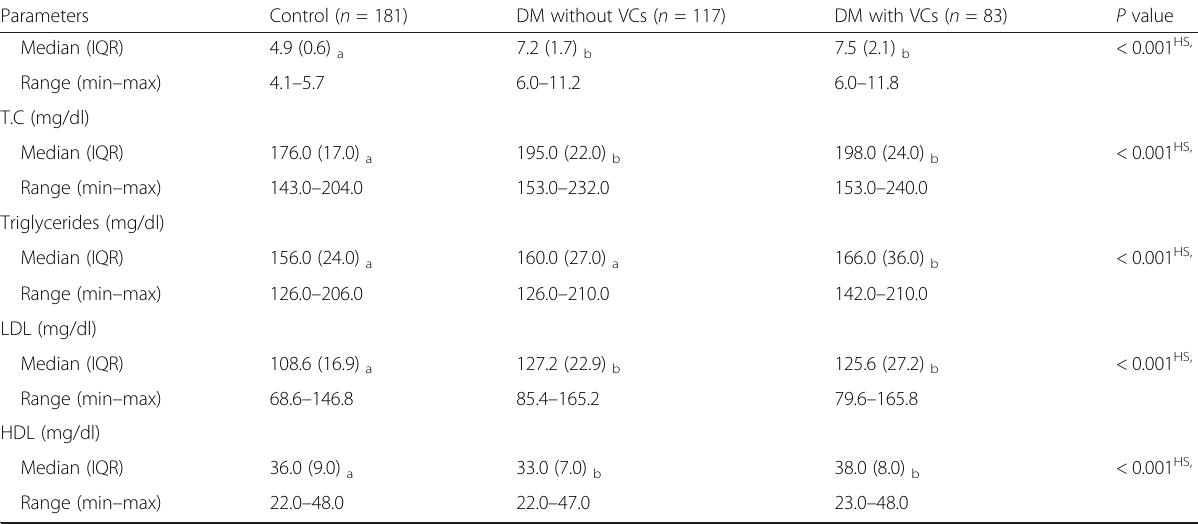
Table 1 Comparison between control, DM without vascular complications, and DM with vascular complications groups regarding demographic and clinical data (Continued)